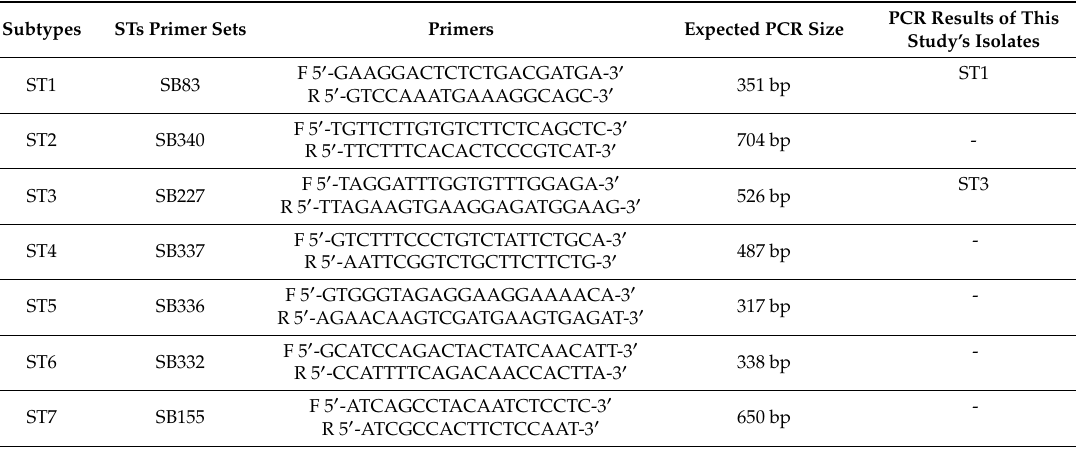
Table 2. PCR genotyping data of Blastocystis